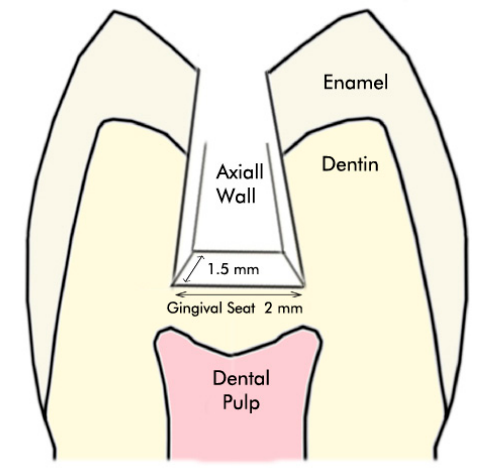
Figure 1. The prepared proximal box from the mesial